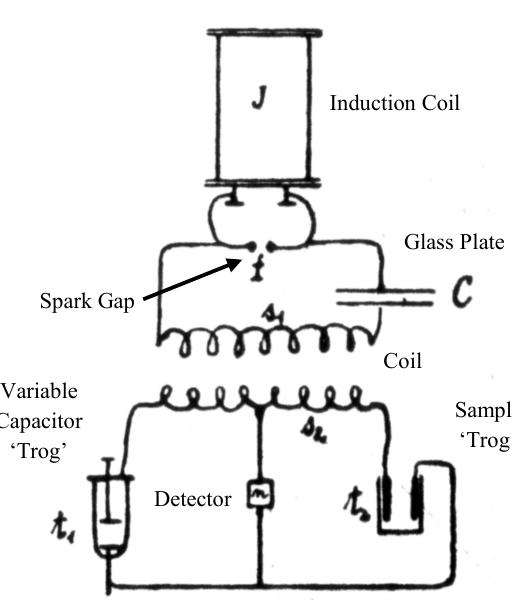
Figure 2 . Based on Höber’s original drawing [1] his signal generator consisted of an induction coil connected to a spark gap. The frequency of the induced transient oscillating current in the external circuit was determined by the capacitance C of a glass plate and the inductance of a coil wound onto a gas lamp. The conductivity of a trough (trog) of vials to mimic a cell sample, or of a sample of compacted red blood cells, was determined by comparing the damping of the oscillating current due to ion conduction against that of a series of NaCl solutions. Different forms of detector were tested to optimise the determination of the damping